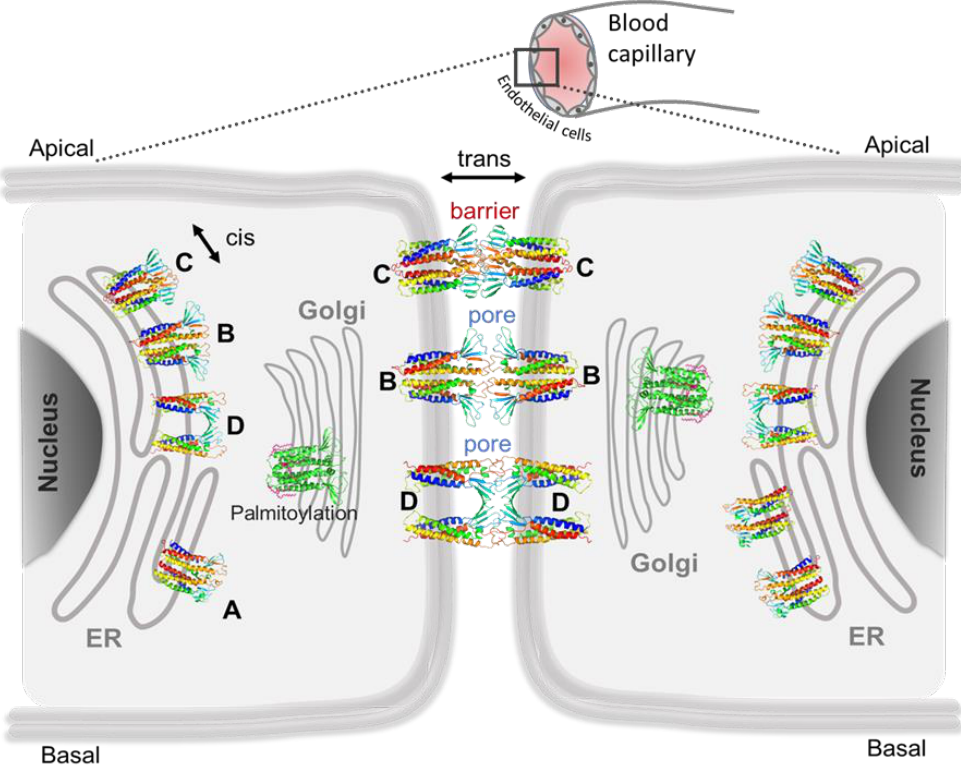
Figure 5. A schematic view of claudin-5 (cid:48) s cis and trans assembly along the secretory pathway. The cis dimerization of claudin-5 proteins in endoplasmic membrane (ER) and Golgi complex membrane can result in multiple conformations that are categorized as dimers A, B, C, and D [94,97,115]; posttranslational modification can influence the relative stability of these dimers [91]; the trans interaction of C dimer pair results in a paracellular barrier, whereas trans interaction of B–B or D–D dimer pairs result in paracellular